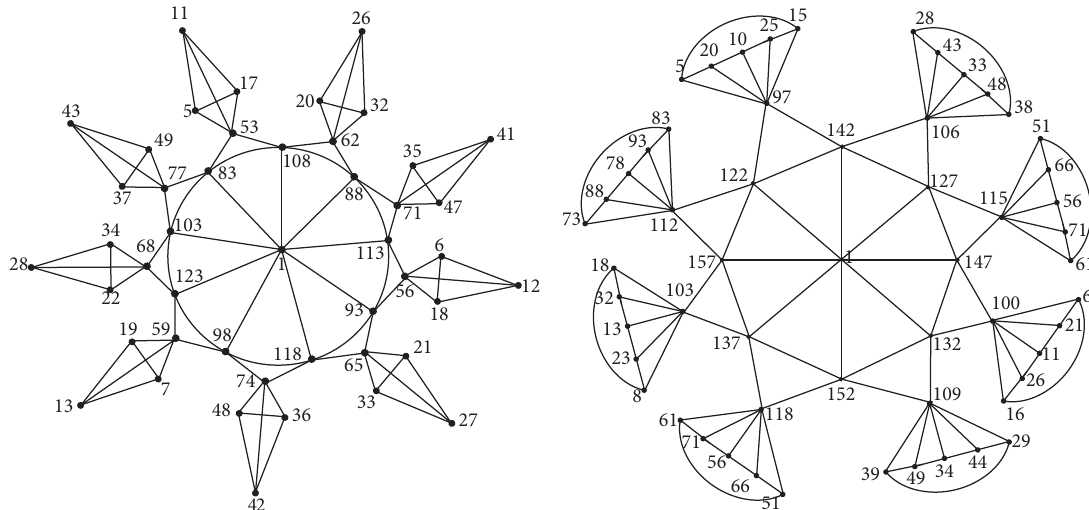
Figure 4: A radio labelling of complete-sun graph CS ( 9 , 4 ) and wheel-sun graph WS ( 8 , 5 )